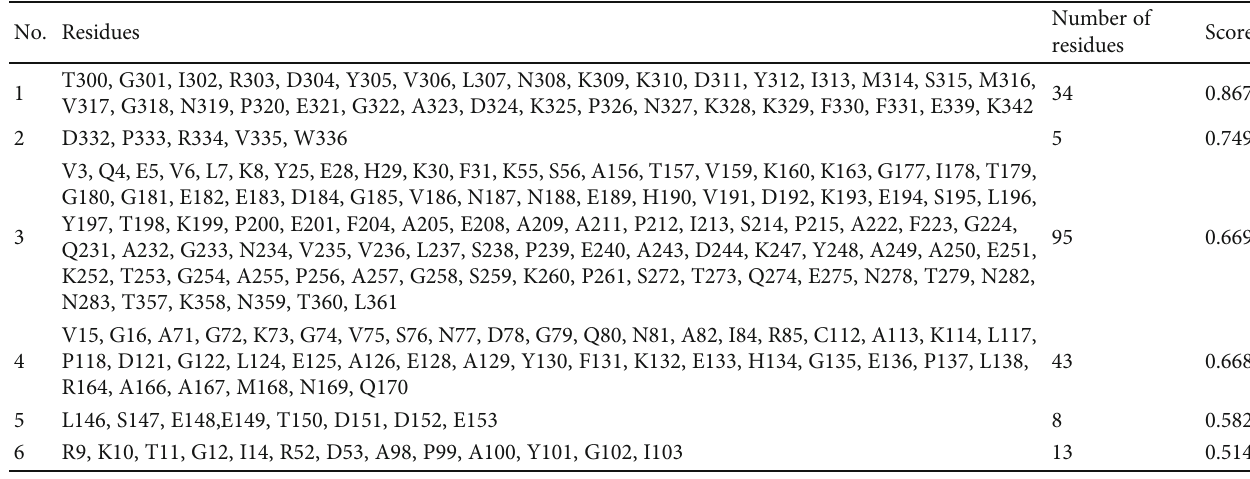
Table 3: List of the promising discontinuous B-cell